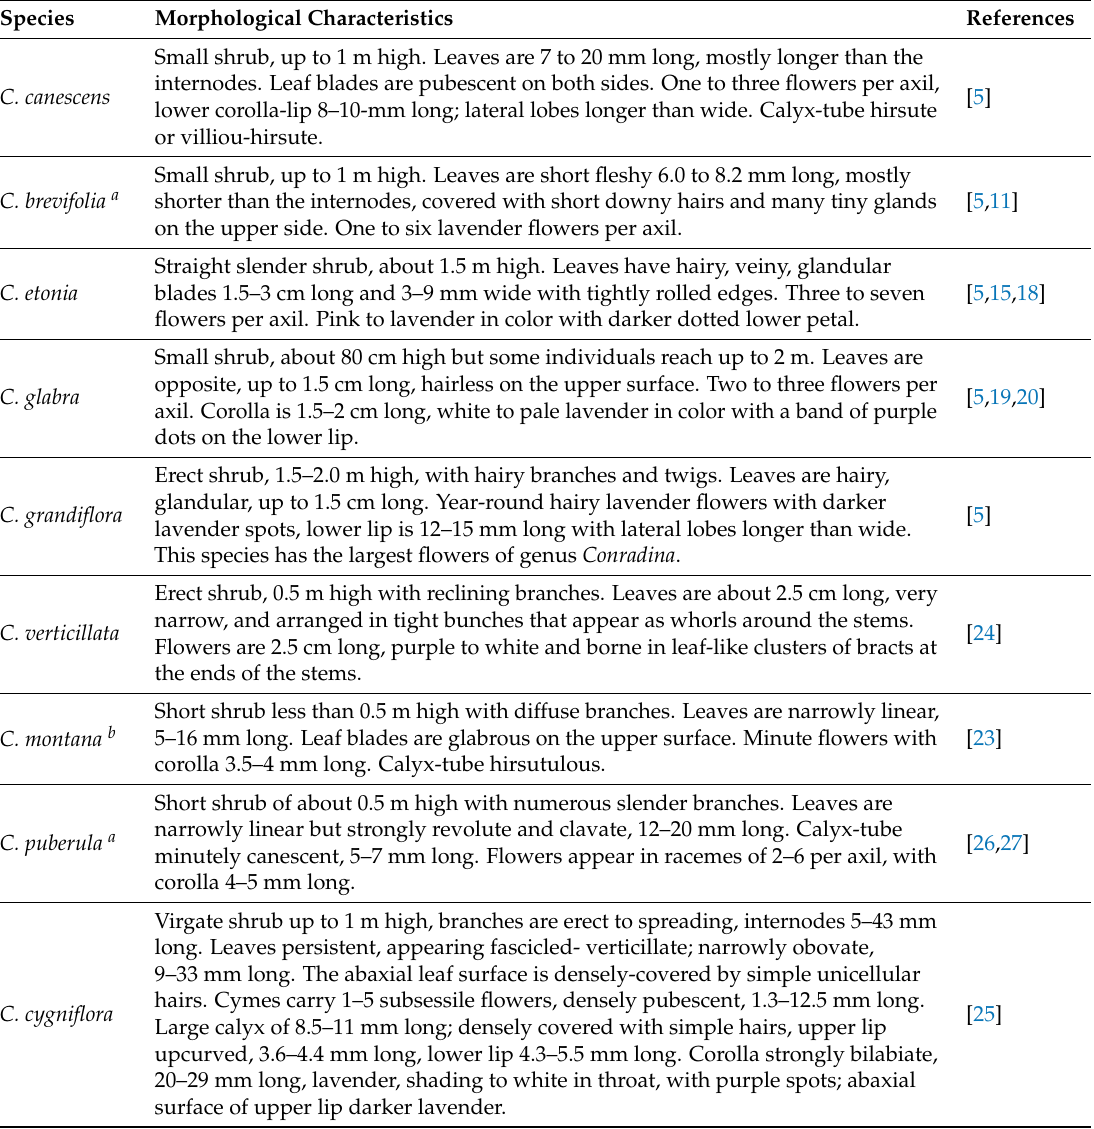
Table 1. Morphological characteristics of Conradina